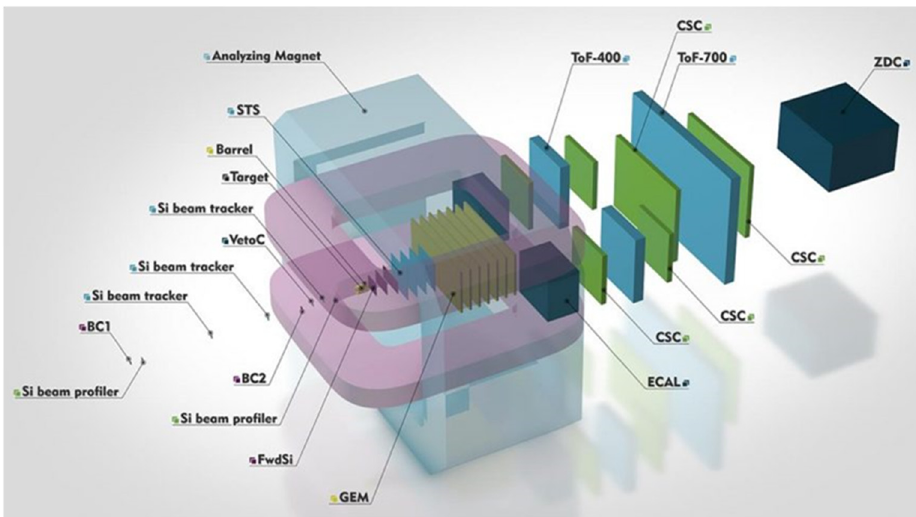
Figure 12. Sketch of the upgraded Baryonic Matter at the Nuclotron (BM@N) experiment [47].